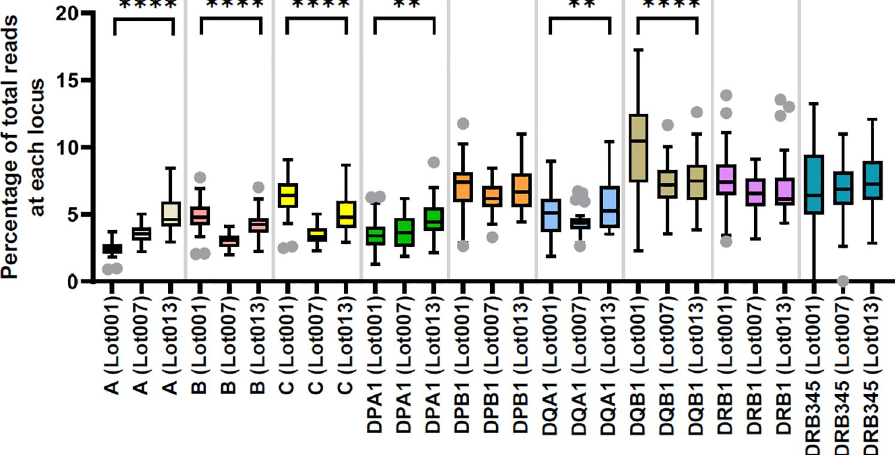
Fig 6. Inter-lot comparison of the percentages of total reads mapped to each locus. Each lot is represented by one run with 32 barcoded samples. Boxes represent the median and interquartile range (IQR); whiskers represent 1.5 IQR. �� P < 0.01, ���� P < 0.0001, by ordinary one-way